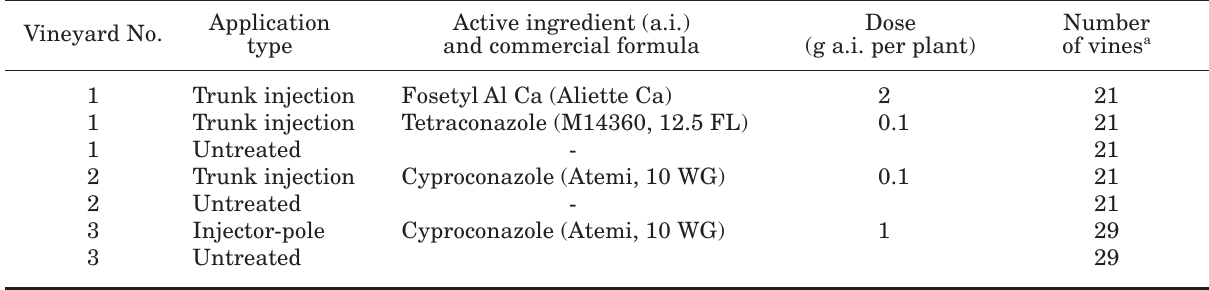
Table 1. Field-trial fungicide application details. Vineyard